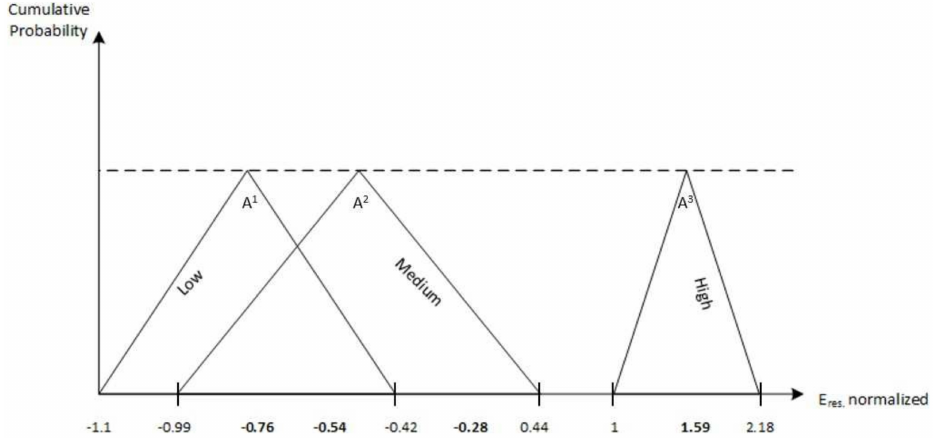
Figure 5. FTS diagram for the case study of Kimmeria,